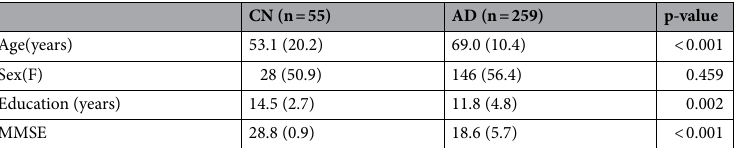
Table 1. Demographics of the study participants. Values are mean (SD) or N (%). Statistical analyses were performed with Chi-square or ’Student’s t -tests. SD Standard deviation, CN Cognitively normal, AD Alzheimer’s disease, MMSE Mini-mental state